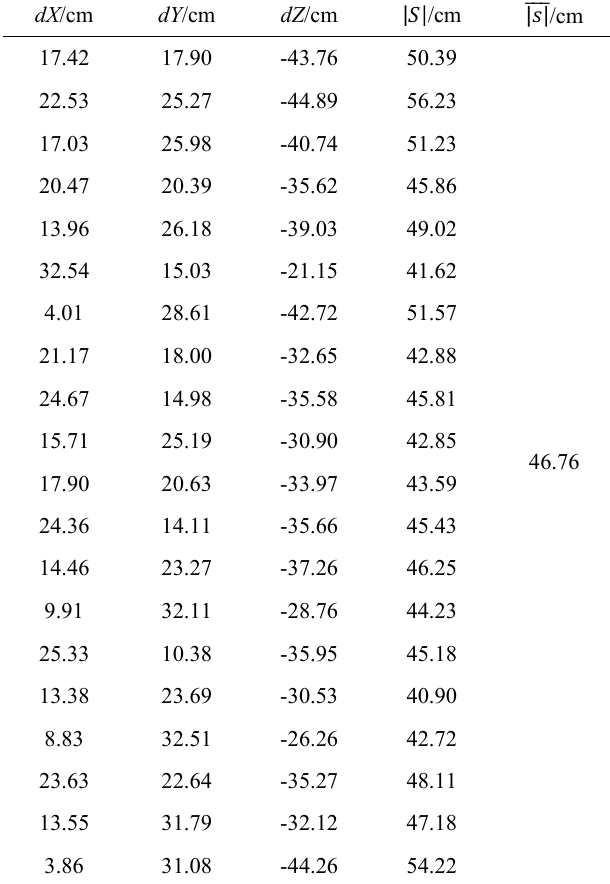
Table 3 . Displacement of Sampling model